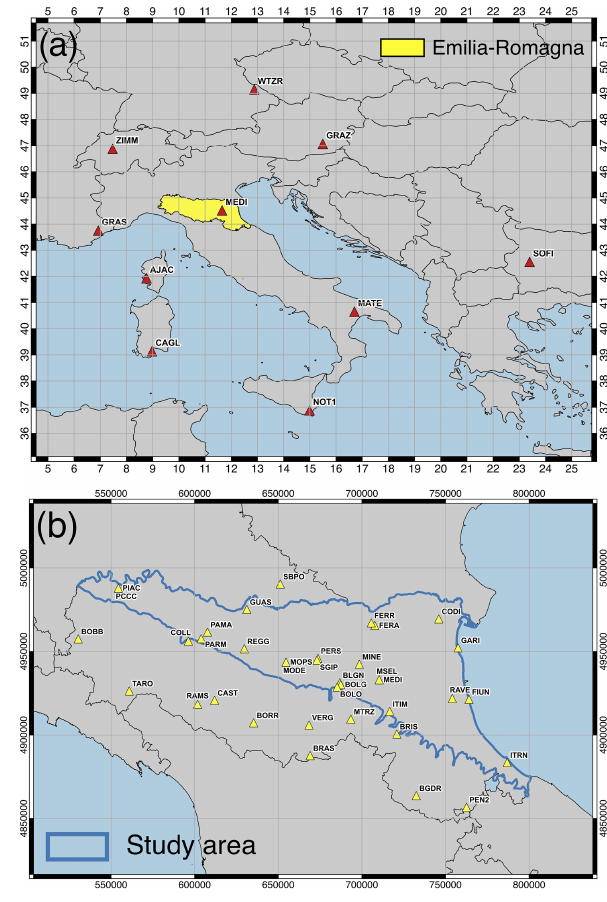
Figure 3. (a) GNSS permanent stations used as reference to frame the Emilia-Romagna geodetic network within the International Ter- restrial Reference Frame (ITRF14). (b) Locations of the GNSS per- manent stations processed for data SAR calibration. In blue the study area.